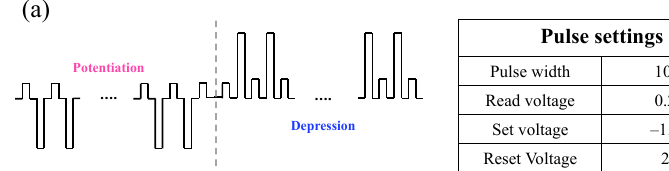
Figure 5. ( a ) Pulse settings used for the potentiation and depression measurement. ( b ) Conductance changes during the 500 consecutive identical pulses. 4. Conclusions In summary, the transparent ITO/WO X /ITO memristor was investigated to mimic the biological synaptic functions for neuromorphic engineering. Two different types of switching behavior were obtained by controlling the voltage during the first reset process. Due to the linear synaptic property, we focused on gradual analog switching which can be obtained by applying partial reset. Long retention above 10 4 s and stable cycling endurance for 300 cycles were observed. We also evaluated the LTP/LTD characteristics which indicated a resemblance to the neurotransmitters in the biological synapse. We